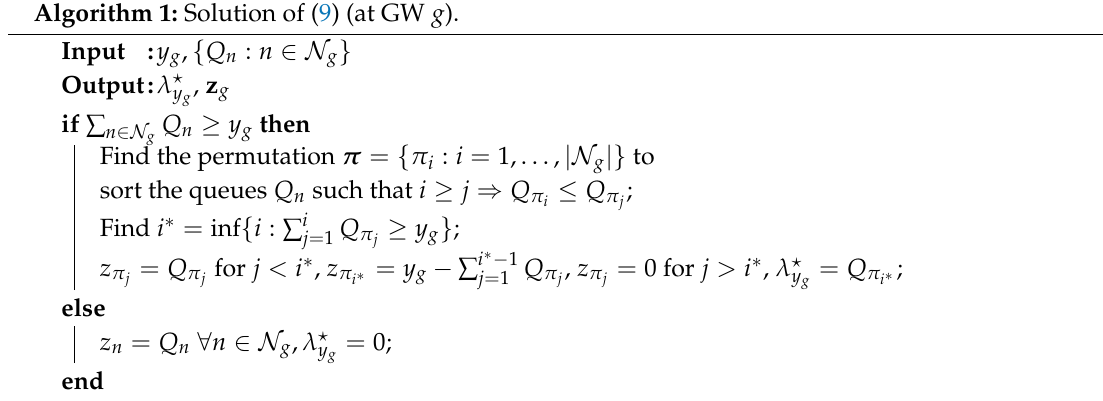
Algorithm 1: Solution of (9) (at GW g